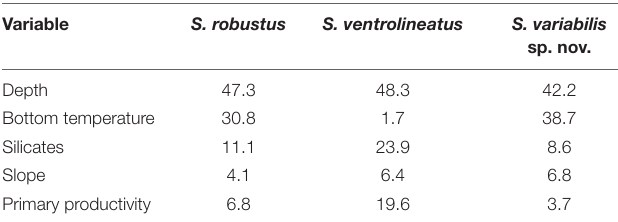
TABLE 2 | Percentage of contribution of environmental layers in the species distribution modeling for each species.